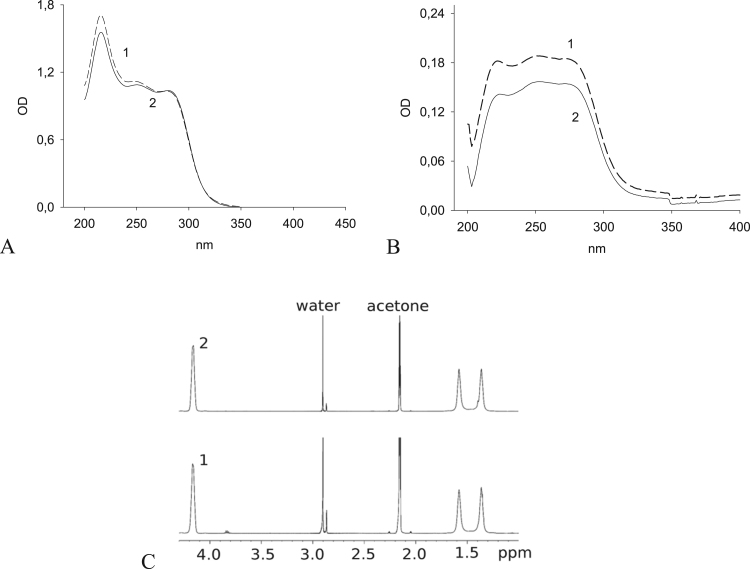
UV and NMR spectra of a sediment (1) and commercial DSF (2) dissolved in ethanol (А), PBS (pH 7.2) (В), and acetone (С). The sediment was obtained in a solution of 10 mM DDC and 250 μM HOCbl in deionized water. The concentration of the crystalline sediment is 30 mg/l in alcohol and 6 mg/l in PBS, and the concentration of commercial DSF is 30 mg/l and 4.25 mg/l, respectively.